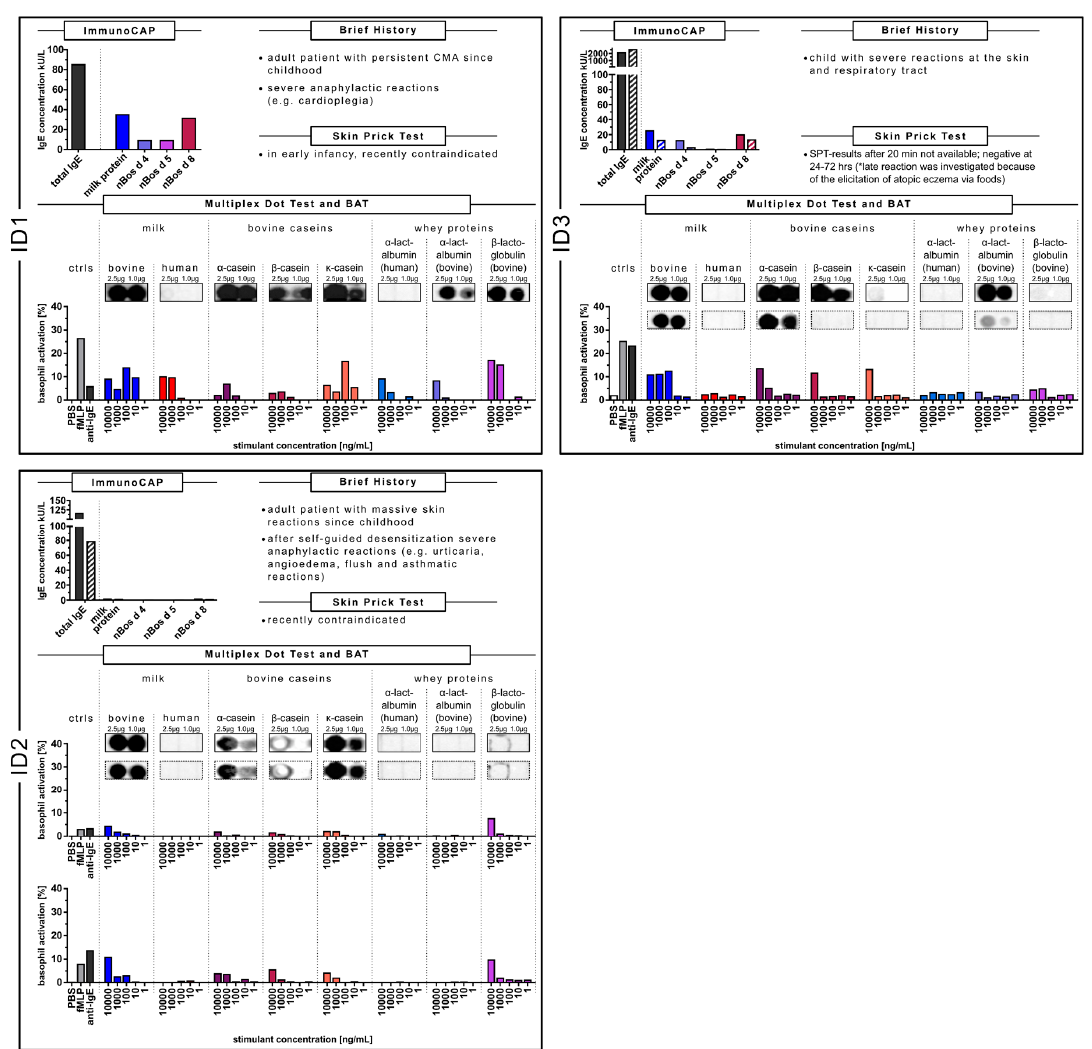
Figure 1. Synopsis of data of the sensitization patterns of ID1, ID2 and ID3 with severe reactions in the ImmunoCAP, multiplex dot test and basophil activation test (BAT). Caseins were associated with this clinical response. CAP data of the cow’s milk allergy (CMA) patients are depicted in a bar graph. The filled bars show the data of the first blood sample, the hatched bars those of the second blood sample. Determination of IgE recognition to whole and single allergens of cow’s milk and human milk in the multiplex dot test. The concentration of the dot-blotted analytes as indicated was 1.0 µ g / µ L and 2.5 µ g / µ L, respectively. The IgE recognition of the first blood sample is given in a box with a solid line, of the second blood sample with a box with a dotted line. The BAT was performed with blood of the patients using whole cow’s milk and human milk as well as single bovine and human milk allergens. Percentages represent CD63 positive basophils determined by flow cytometric analysis. Blood sample stimulation was conducted with the analytes as indicated. fMLP, anti-IgE were run as positive controls, PBS as negative